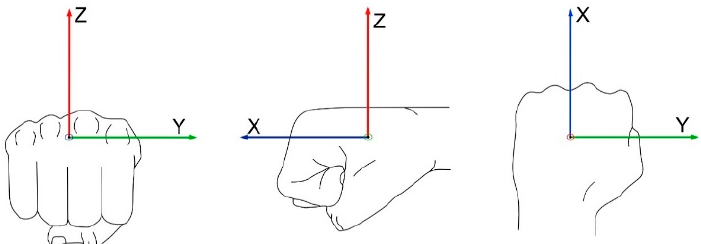
Figure 2. Body coordinate system of the boxer’s fist (X: anterior positive, posterior negative (rotation around the sagittal axis); Y: medial positive, lateral negative (rotation around the transverse axis); Z: dorsal positive, palmar negative (rotation around the longitudinal axis) .